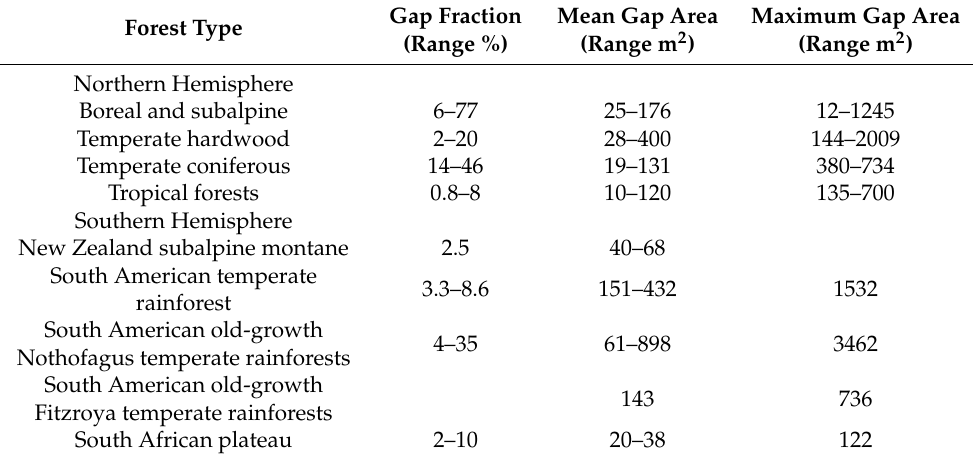
Table 4. Gap characteristics found in the forests of the world. Data obtained from [53–55,57–59]. Forest